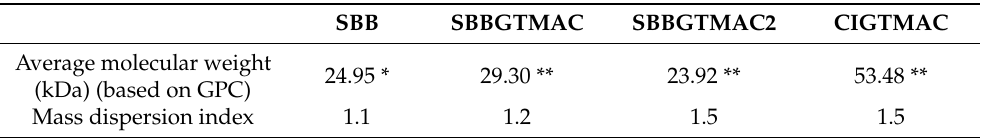
Table 3. The molecular weight determined from GPC measurements for crude polysaccharide and corresponding cationic